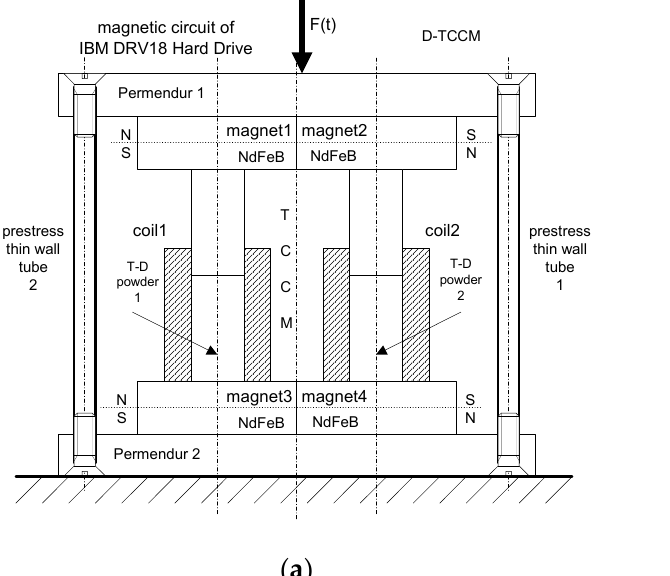
Figure 2. DTCCM harvester: ( a ) scheme, ( b ) real device.